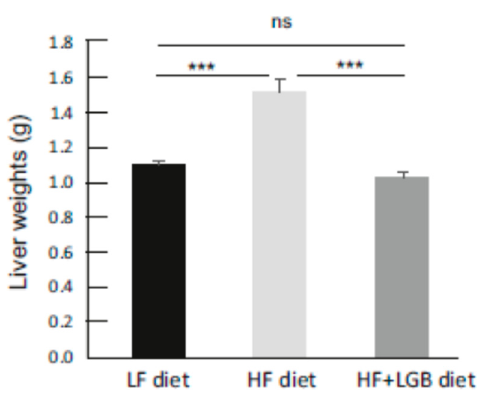
Figure 2. Liver weights of the mice at the end of the study. Animals received low-fat diet (LF diet, black column), high-fat diet (HF diet, light grey column) or high-fat diet supplemented with lingonberry (HF + LGB diet, grey column). The results are expressed as grams (g). Values represent mean + SEM, n = 9 mice per group. One-way ANOVA with Bonferroni post-test was used in the statistical analysis, *** = p < 0.001 and ns = not significant.